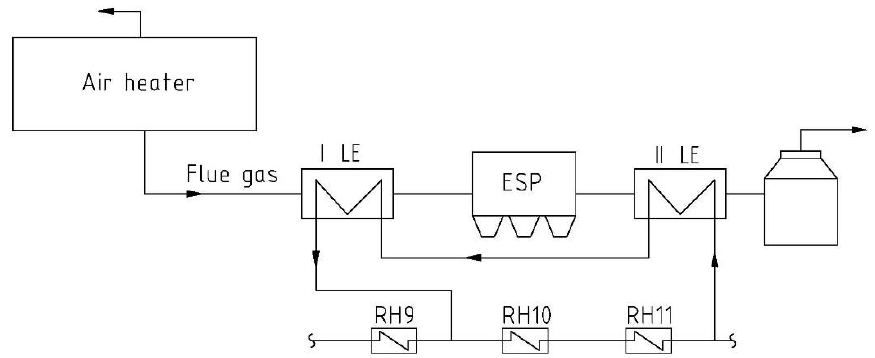
Figure 1. Conventional waste heat utilization system.